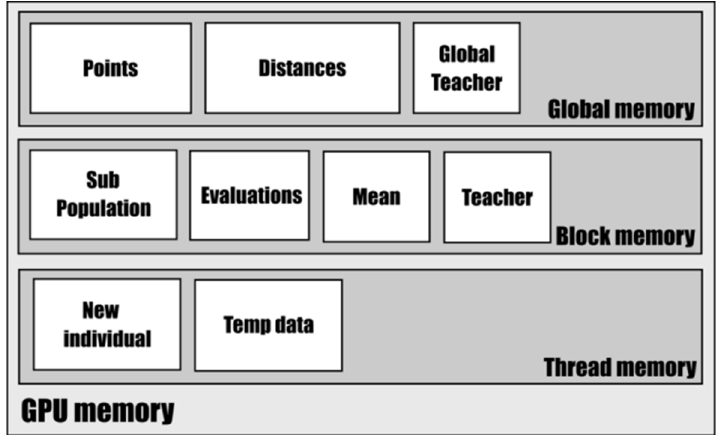
Figure 5. Organization of the Compute Unified Device Architecture (CUDA) memory.